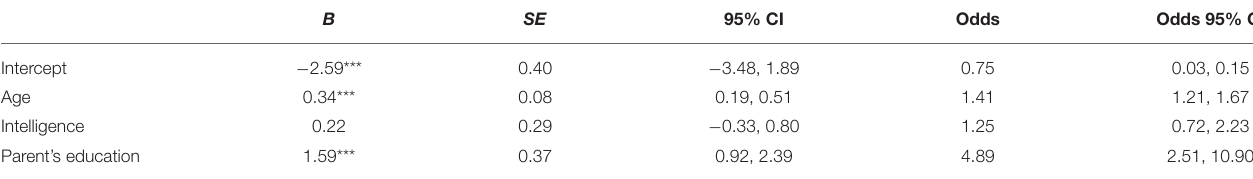
TABLE 4 | Logistic regression predicting signing at least one false